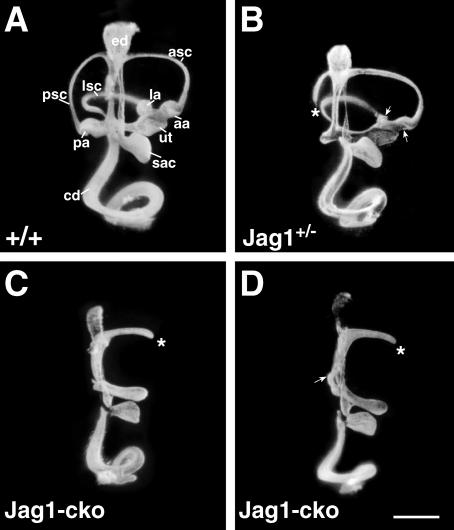
Inner Ear Dysmorphology in Jag1
+/− and Jag1-cko EmbryosE15.5 inner ears that have been paintfilled to display their overall morphology.(A) Wild-type inner ear showing normal morphology. Structures are labeled as follows: aa, anterior ampulla; asc, anterior semicircular canal; cd, cochlea duct; ed, endolymphatic duct; la, lateral ampulla; lsc, lateral semicircular canal; pa, posterior ampulla; psc, posterior semicircular canal; sac, saccule; ut, utricle.(B) Jag1 heterozygote inner ears (either Jag1del1/+ or Foxg1-Cre/+; Jag1flox/+) display truncated posterior semicircular canals and missing ampullae (asterisk). Arrows point to the anterior and posterior ampullae, which are small compared to the wild-type control (A).(C and D) A much more severe phenotype is observed in Jag1-cko animals. There are no ampullae and little semicircular canal development; an asterisk indicates a remnant of the anterior canal. In (D), there is also a remnant of the lateral canal (arrow). The utricle and saccule are smaller and the cochleae are shorter and undercoiled. Scale bar = 500μm.